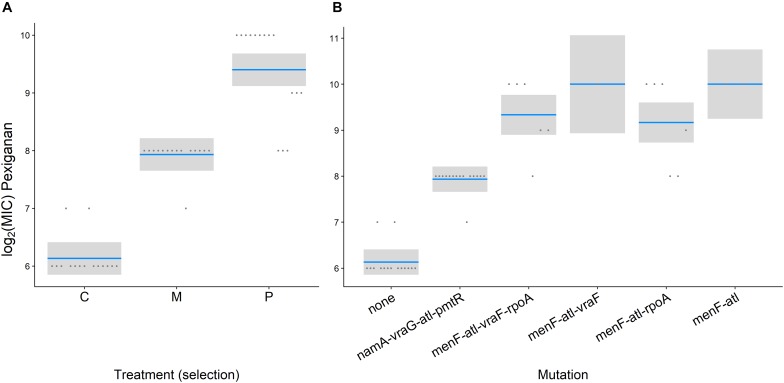
Log2 MIC of pexiganan and melittin resistant S. aureus strains compared to procedural controls tested against pexiganan separated by treatment (A) or by mutation (B) (C and none: unselected control, M: melittin-selected strains with mutation in namA, vraG, atl, and pmtR gene loci, P: pexiganan-selected strains segregated into four genotype variants with mutation in menF, atl, and vraF, rpoA or both, blue line: mean, gray box: 95% confidence intervals). According to minimum inhibition sensitivity test, MIC pexiganan segregated by treatment (F(2,40) = 143.2300, p < 0.0001, Figure 1A) but not by mutation (F(2,40) = 1.8769, p = 0.166, Figure 1B).